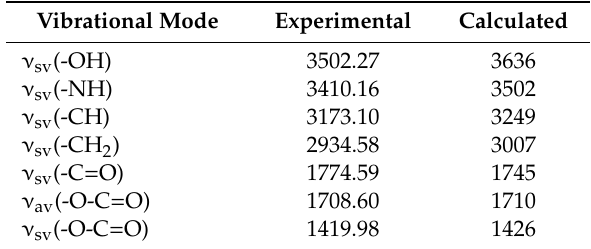
Table 1. Some selected experimental and calculated frequencies (cm − 1 ) of IM + –NPG − –HYD salt. Vibrational Mode Experimental Calculated ν sv (-OH) 3502.27 3636